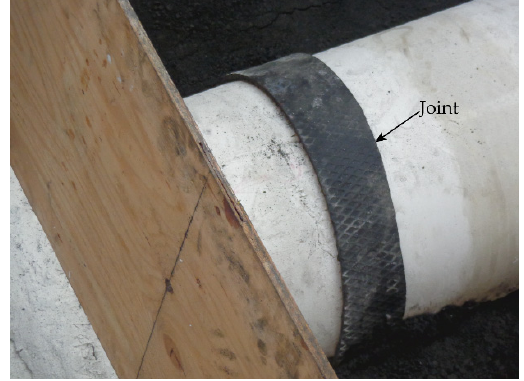
Figure 10. Jointed lining segments.